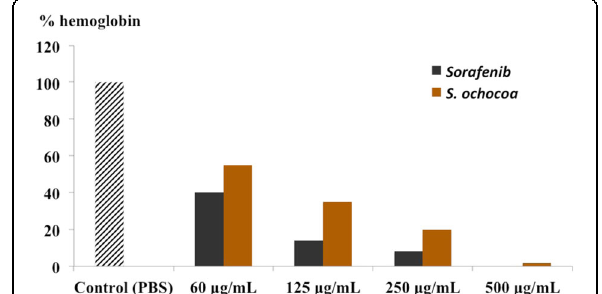
Fig. 3 Haemoglobin content of CAM sections detected by Drabkin ’ s assay. The hemoglobin content in the CAM sections was determined by Drabkin method. As in the case of macroscopic observation of CAM that showed that the number of blood vessel branches was concentration dependent, so the present figure shows a hemoglobin content dependent on the concentration of S. Ochocoa water extract and